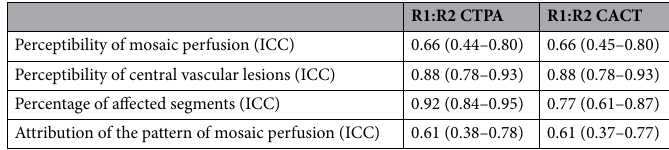
Table 2. Inter-observer agreement between Reader 1 (R1) and Reader 2 (R2).